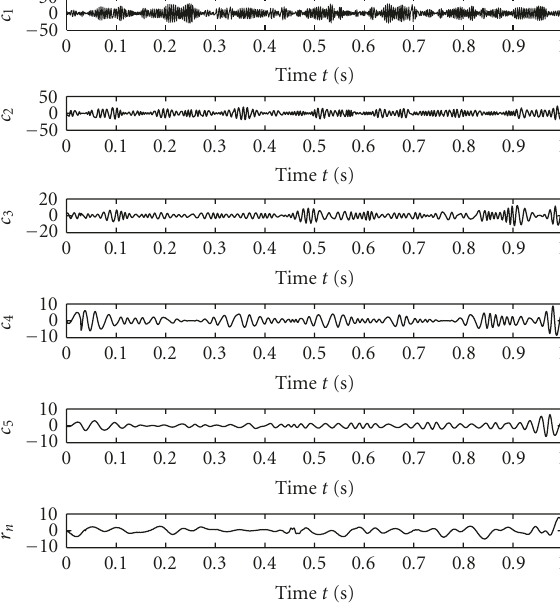
Figure 2: The EMD results of a gear vibration signal.